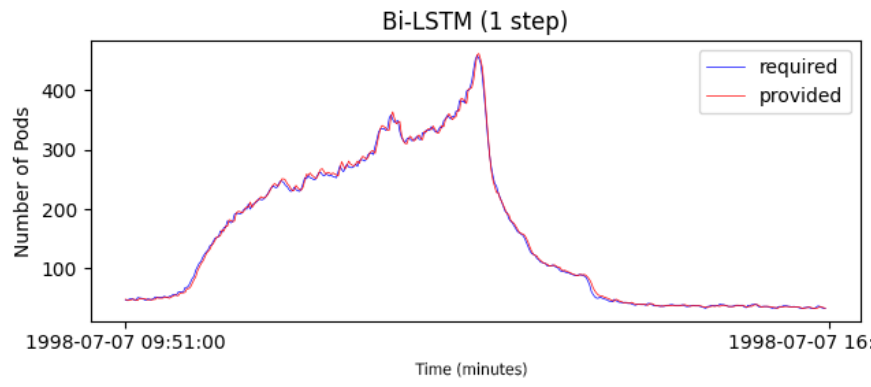
Figure 17. Number of pods produced by the Bi-LSTM